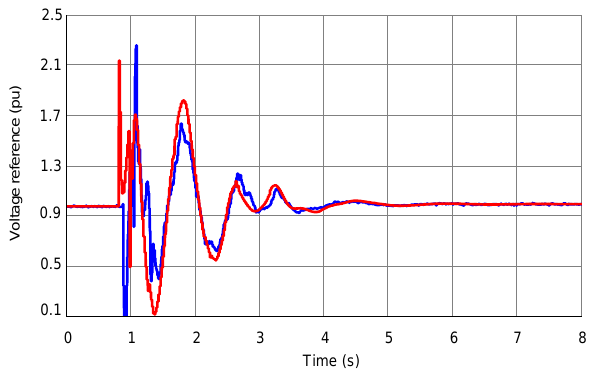
Figure 12. SVC voltage reference due to a 10-cycle fault: RTDS-based WAC-SVC (red), and delay-compensated HIL-based WAC-SVC (blue).